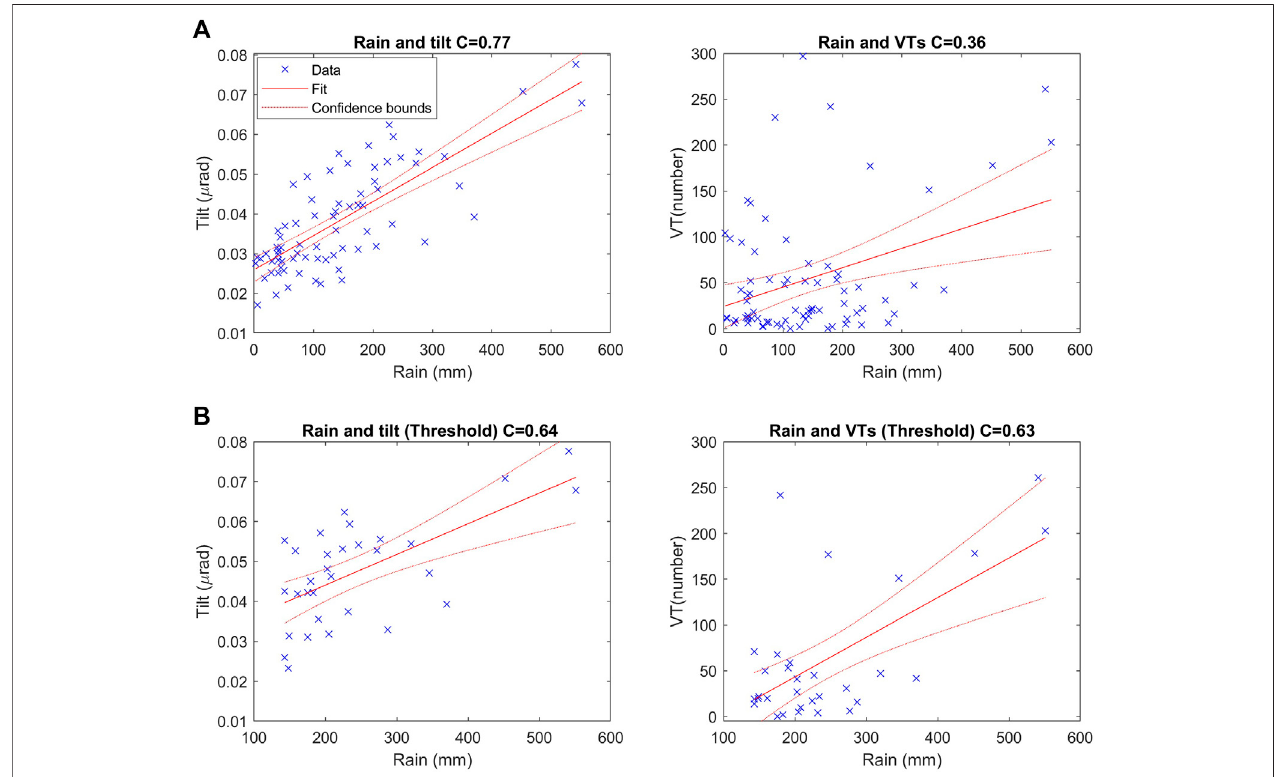
FIGURE4| ResultsoftheregressionanalysisatCampiFlegrei. (A) Ontheleft,linearregressionbetweenrainfallamountandRMStilt.Ontheright,linearregression betweenrainfallamountandVTnumber.Thereddottedlinesmarkthe95%con fi denceinterval.Allthevariableshavebeenestimatedovera30-daymovingwindow. (B) On the left, linear regression between rainfall amount and RMS tilt, considering only rainfall values exceeding the 60th percentile of the 6-years distribution. On the right, linear regression between rainfall amount and VT number using the same rain threshold. The red dotted lines mark the 95% con fi dence interval. All the variables have been estimated over 30-day moving